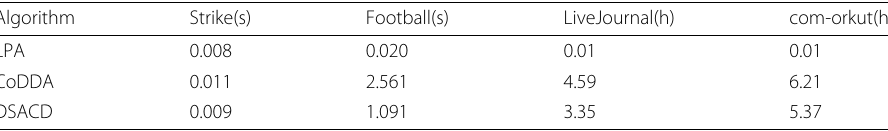
Table 9 Time comparison with other community detection